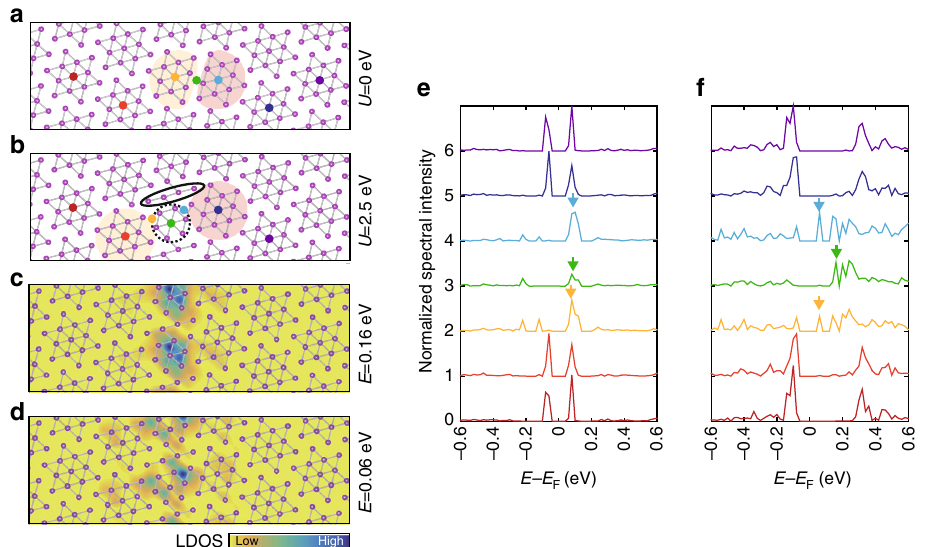
Fig. 3 Theoretical calculations of U -dependent domain wall and edge reconstruction. a , b Atomic structure of the second domain walls at U = 0 and 2.50 eV. Ta atoms are indicated by violet spheres . Gray lines indicate the bonding between the nearest neighbors Ta atoms with shorter distances than the primitive unit vector of ×1 structure. c , d Calculated spatial distribution of the domain wall and edge states. e , f LDOS spectra are acquired at the position marked by colored spheres in a , b . The small arrows indicate the in-gap states at domain wall and edges. All spectra are normalized by their maximum value and equally shifted for